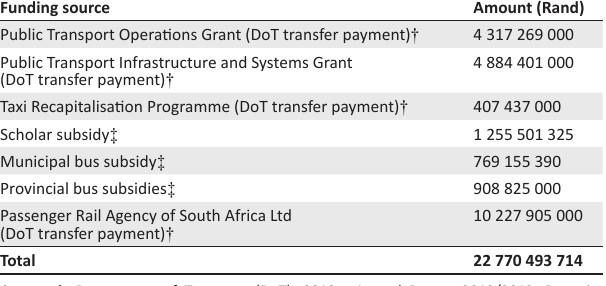
TABLE 2: Different funding sources for public transport operational subsidies and capital projects (2012/2013).